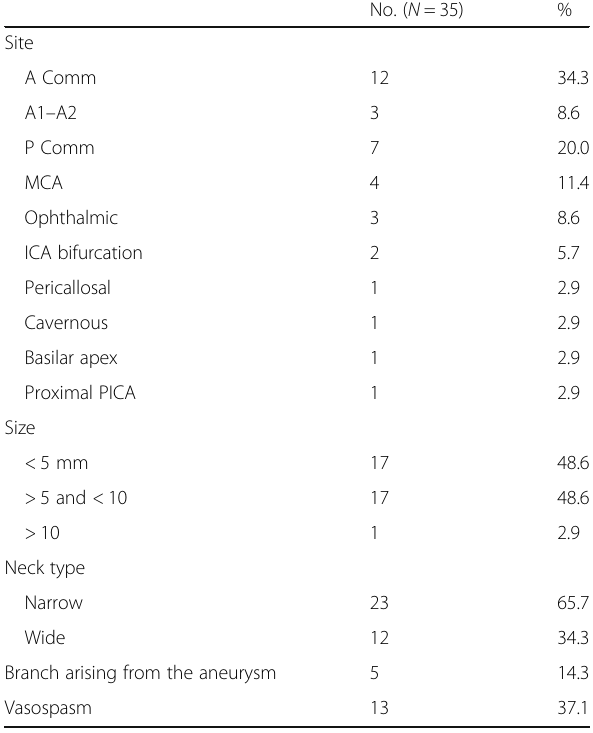
Table 2 Angiographic assessment